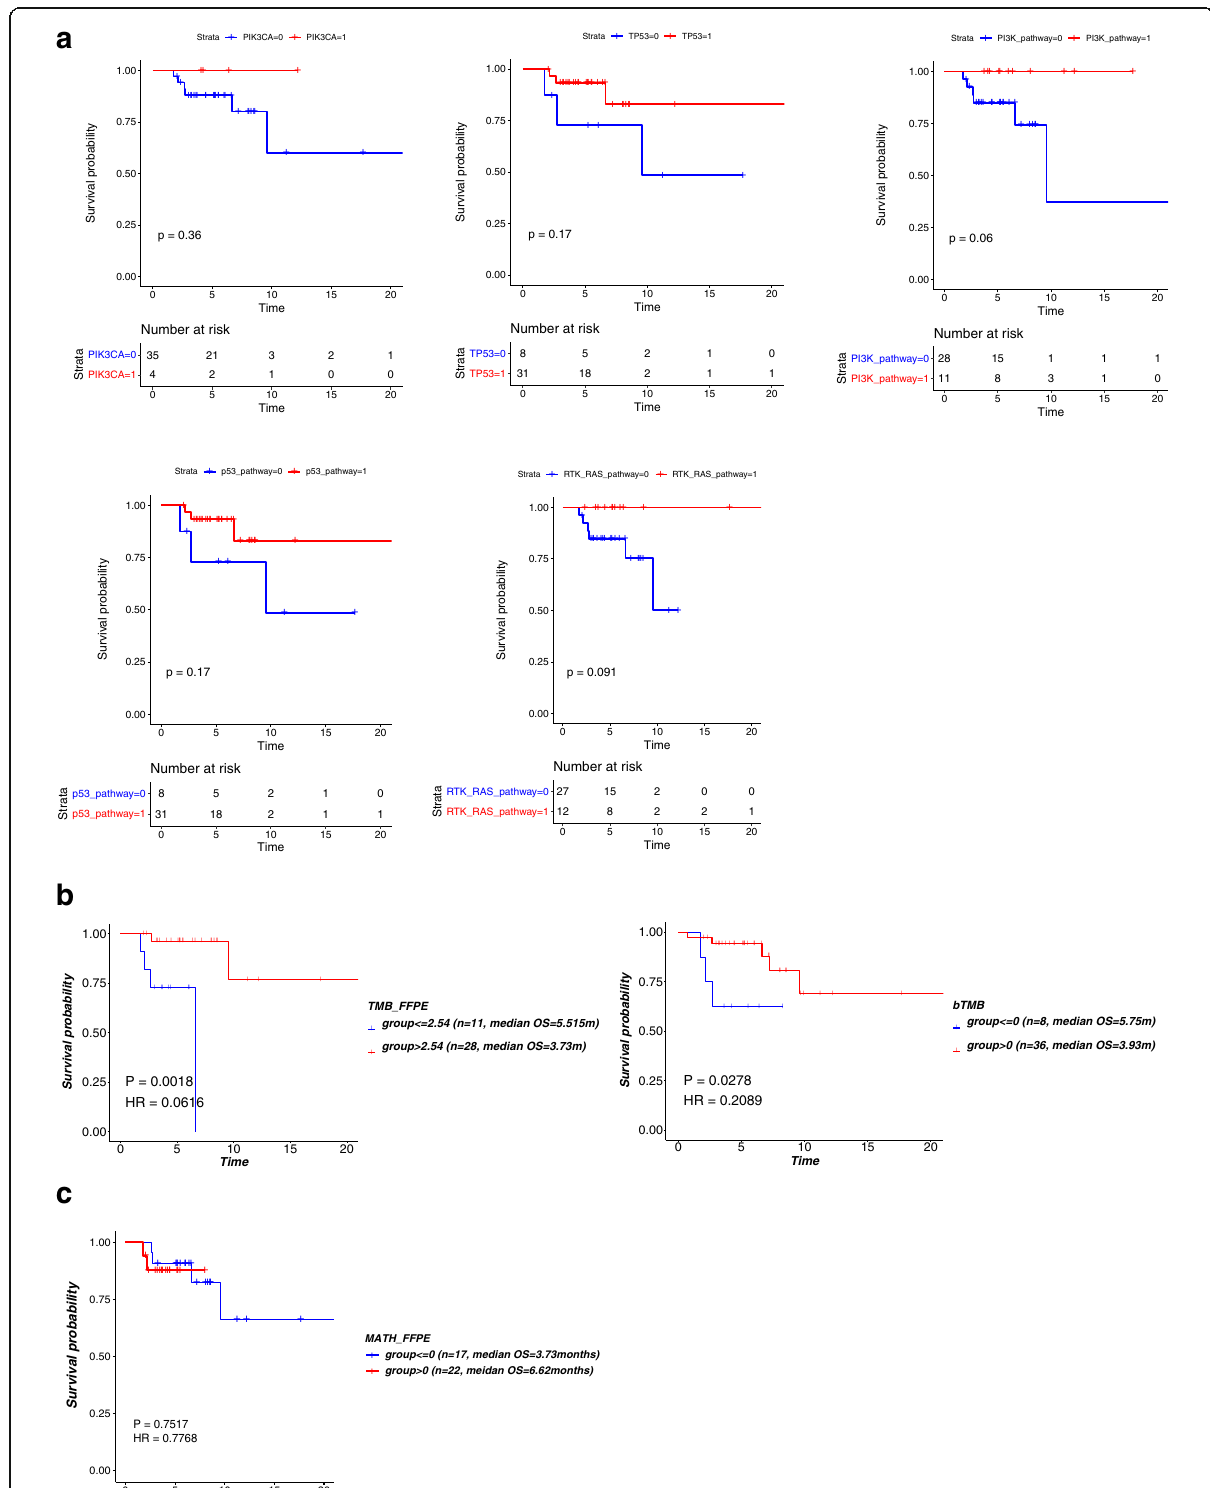
Fig. 2 The relationship between gene/signal pathway mutations, TMB and MATH and OS. ( A ) Survival analysis based on mutations in different gene/signaling pathway, ( B ) Survival analysis based on TMB/bTMB values, ( C ) Survival analysis based on MATH